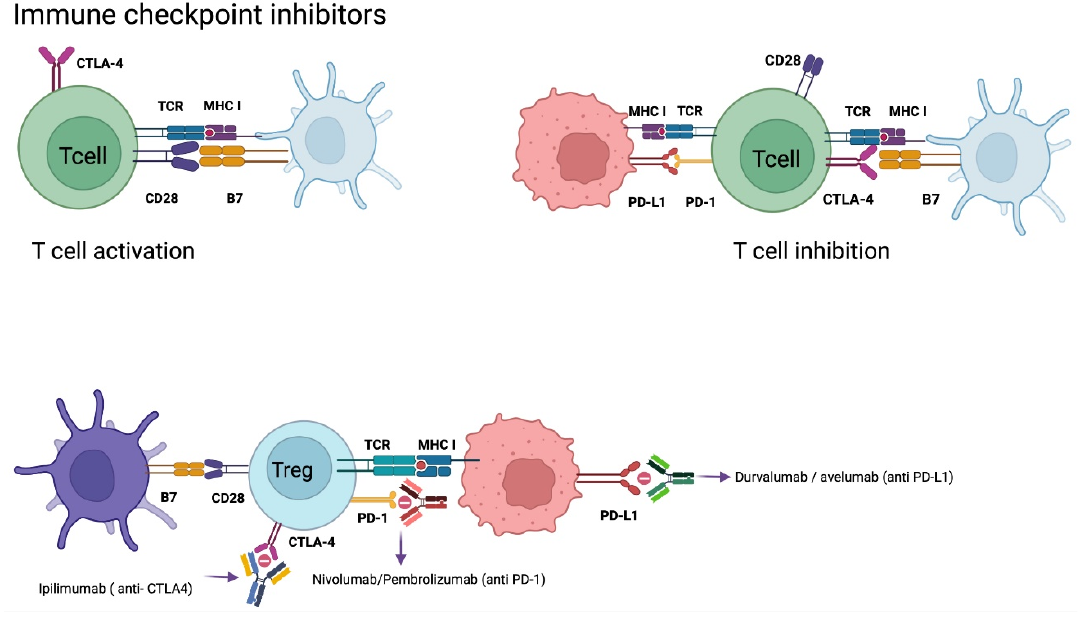
Figure 4. Checkpoint Inhibitors Mechanism of Action. Tumor cells evade the immune system as a defense mechanism. PD-L1 expression on tumor cells binds to PD-1 expressed on T cells, generating anergy of cytotoxic T cells. CTLA-4 expressed on T cells when it binds to B7 increases the expression of T-regs, generating an immunosuppressive response. CTLA-4 has a higher affinity for B7 than CD28 (B7 and CD28 when bound activate cytotoxic T cells). Monoclonal antibodies antagonize CTLA-4, PD-1, and PD-L1 preventing suppression of the immune response by cytotoxic T cells. Abbreviations: CTLA-4, cytotoxic T lymphocyte antigen 4; DC, dendritic cell; MHC, major histocompatibility complex; PD-L1, programmed cell death ligand-1; PD-1, programmed cell death-1; TCR, T-cell receptor; T-regs, regulatory T cells. Created with BioRender.com.